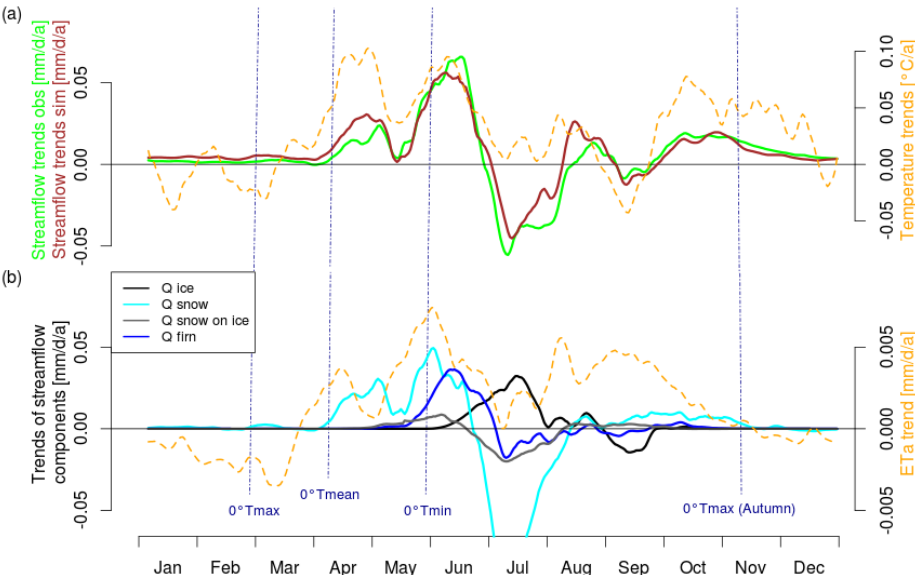
Figure 9. ( a ) Daily trends of observed and simulated streamflow along with temperature trends at the Brunau catchment (1980–2007); ( b ) Daily trends of the most important simulated streamflow components along with ETa trends (1980–2007). Please note the different scaling of the axes of streamflow component trends and ETa trends in (b).